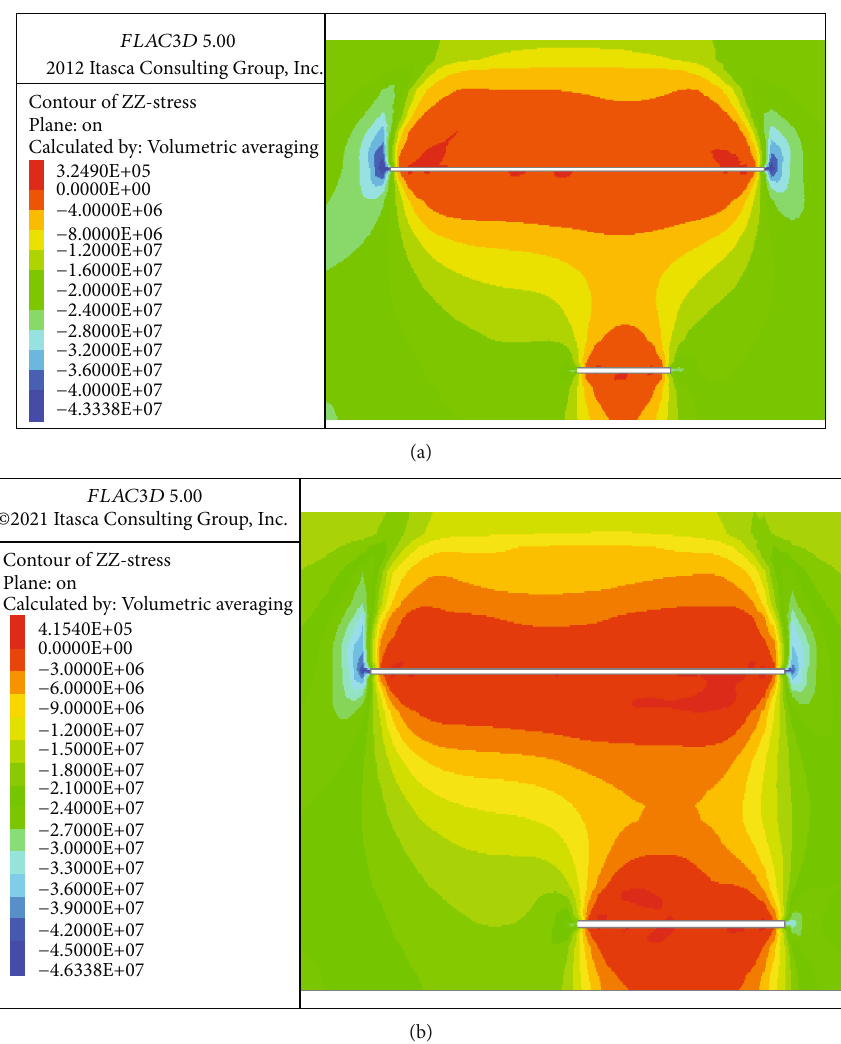
Figure 18: Vertical stress distribution of propulsion in the J coal seam as the working face is pushed to (a) 100 m, (b) 200